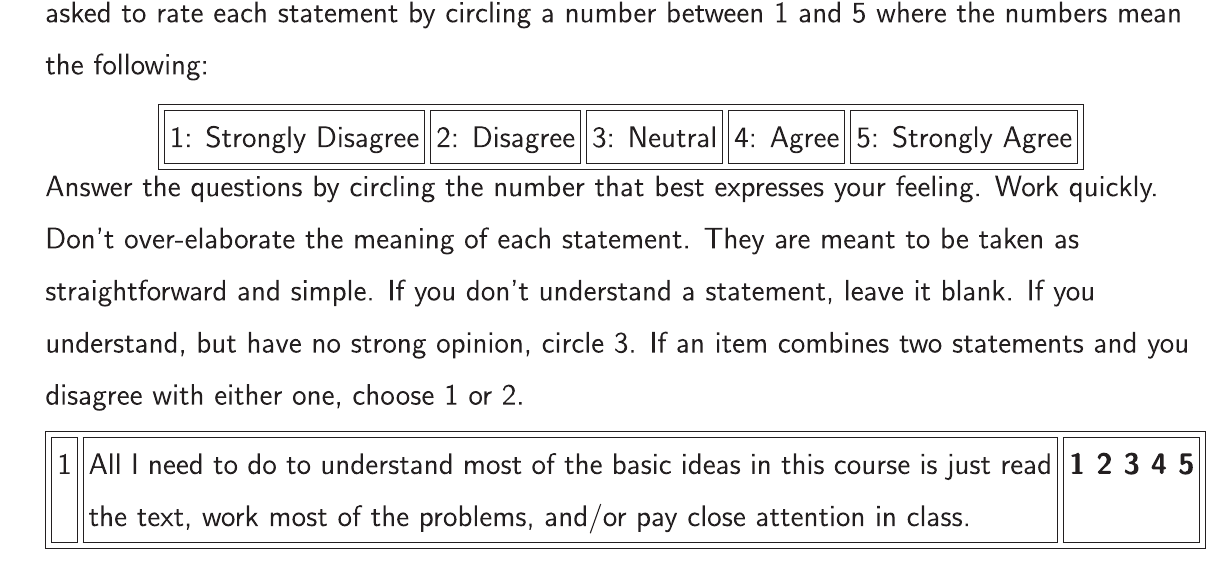
FIG. 6. An example of a Likert-scale item from Redish et al. [28]. Data are coded as